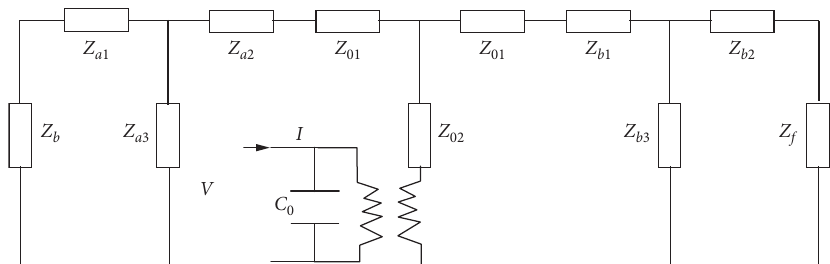
Figure 2: The equivalent circuit of the transducer.